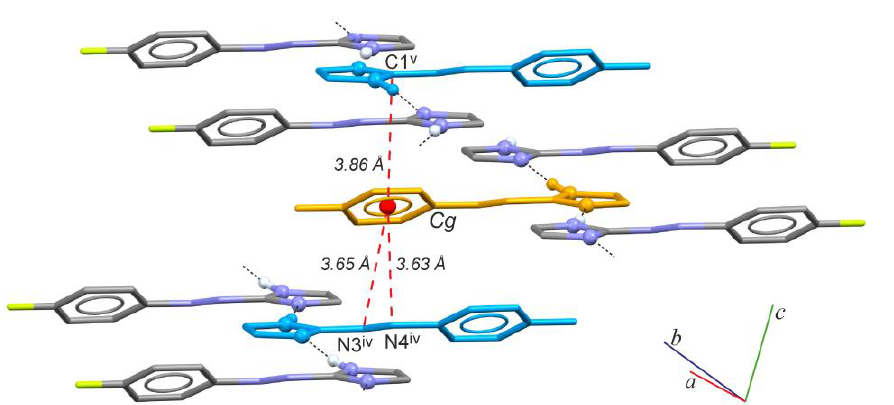
Figure 3. Intermolecular interactions between a central molecule (orange) and two neighboring molecules (blue) belonging to two adjacent molecular layers parallel to the (121) plane. Symmetry codes: (iv) ‒x + 1, ‒y, ‒z + 1; (v) ‒x + 1, ‒y + 1, ‒z + 1. Table 2 . Hydrogen-bond geometry (Å , °).